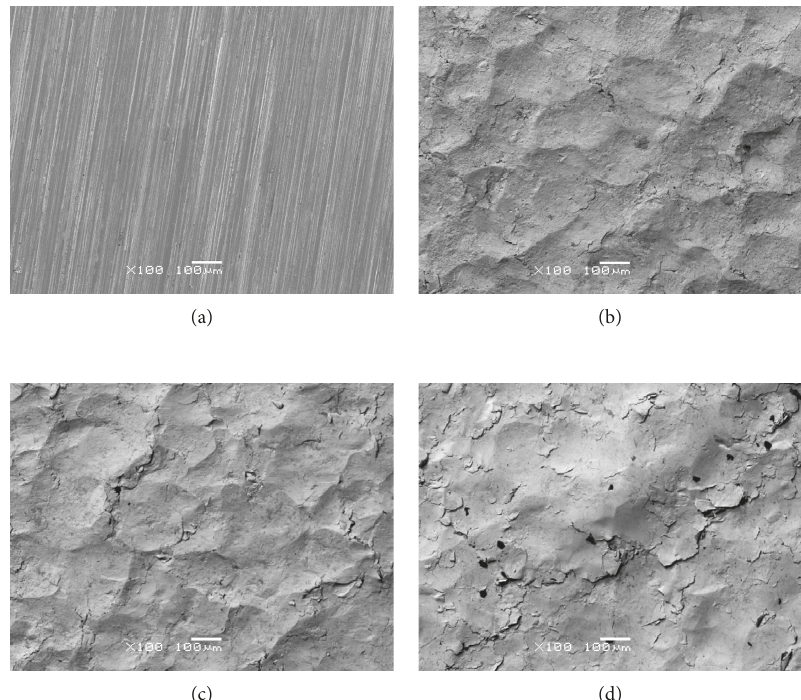
Figure 1: Metallographic photos taken on SEM: (a) initial substrates; (b) shot-peened substrate ( t (cid:31) 120 s, p (cid:31) 0.45MPa); (c) shot-peened substrate ( t (cid:31) 360s, p (cid:31) 0.45MPa); (d) shot-peened substrate ( t (cid:31) 600s, p (cid:31) 0.45MPa).